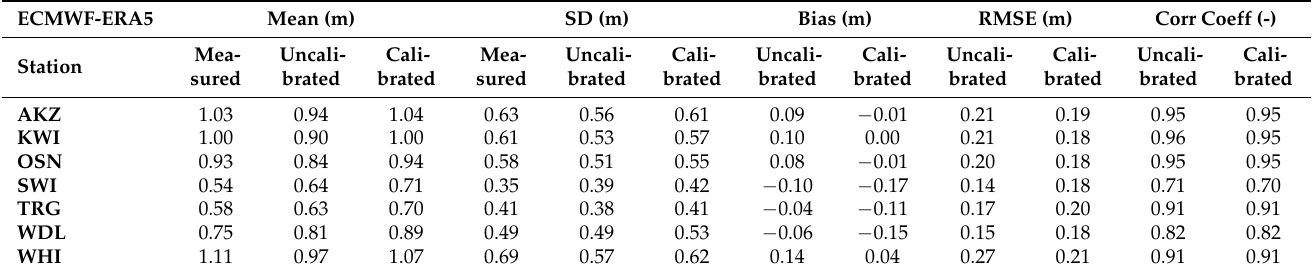
Table 7. Significant wave height statistical parameters calculated for the calibrated and uncalibrated SWAN models, 2.5 km × 2.5 km computational grid, forced by the ECMWF-ERA5 database.